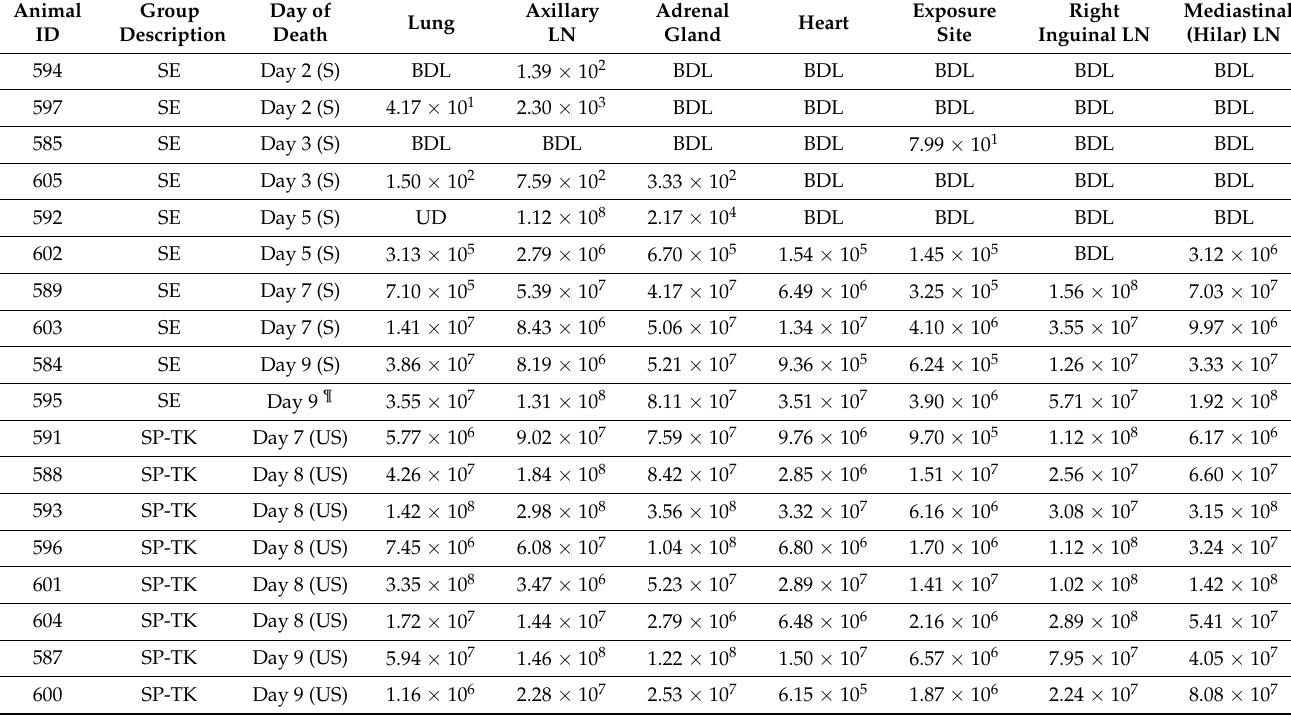
Table 5. Viral load in tissues as determined by plaque assay (plaque-forming units/gram of tissue). Animal